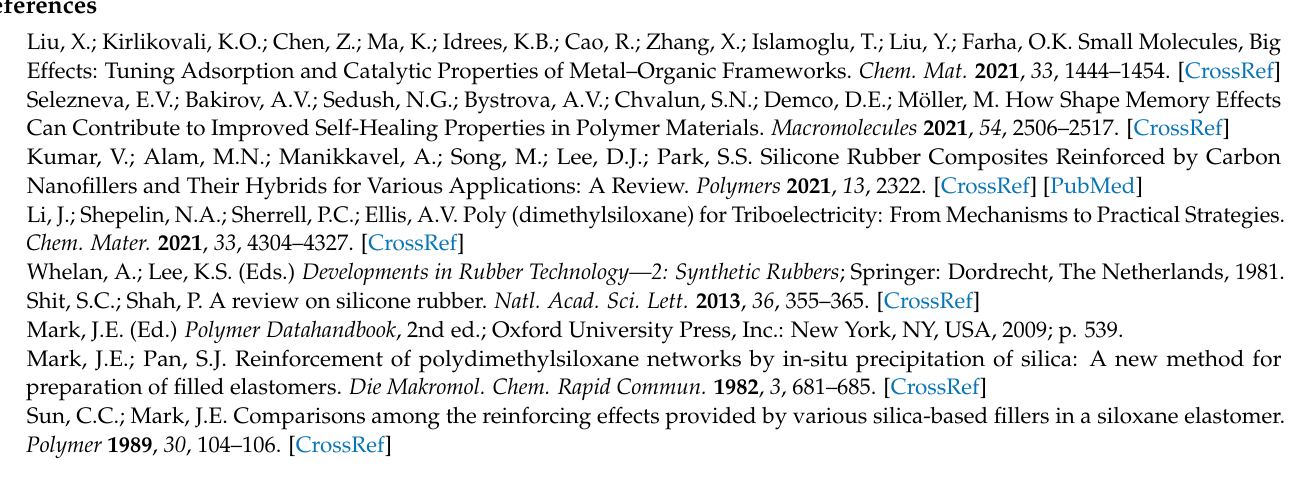
curve of P3 , Figure S4: GPC curve of M2 and M2* , Figure S5: GPC curve of M3 , Figure S5: IR spectra of P3 and composites before and after